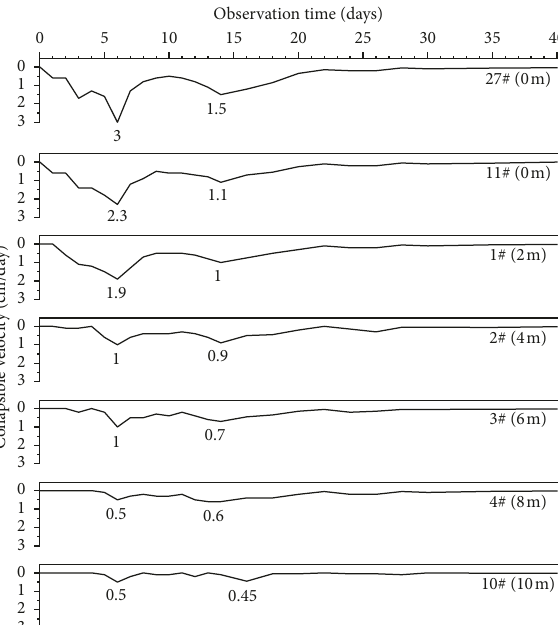
Figure 8: The collapsibility velocity of each benchmark. Because the irrigation process was interrupted for three days, the collapsibility velocity curve of the irrigation appears different from the typical curve, that is, there is a peak value before and after the interruption. The second peak is smaller than the first one, and the difference between these two peaks decreases with the increase of